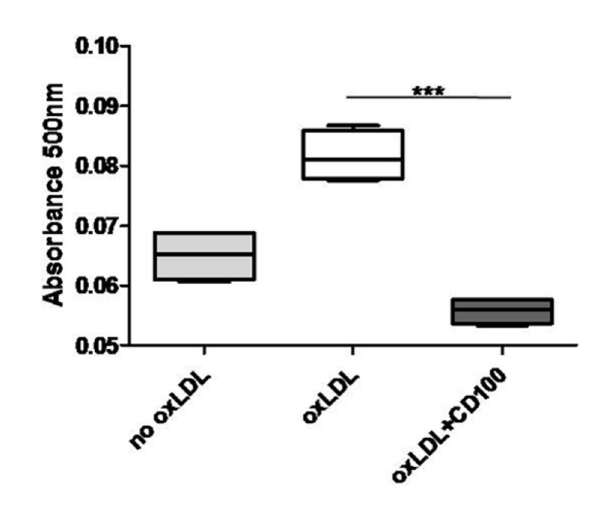
Figure 7. CD100 protein reduces oxLDL incorporation in macrophages. Optical density indicating incorporation of oxLDL by PB macrophages incubated or not with oxLDL or oxLDL and CD100. Mean ± SD of 5 independent experiments (*** p≤0.001).